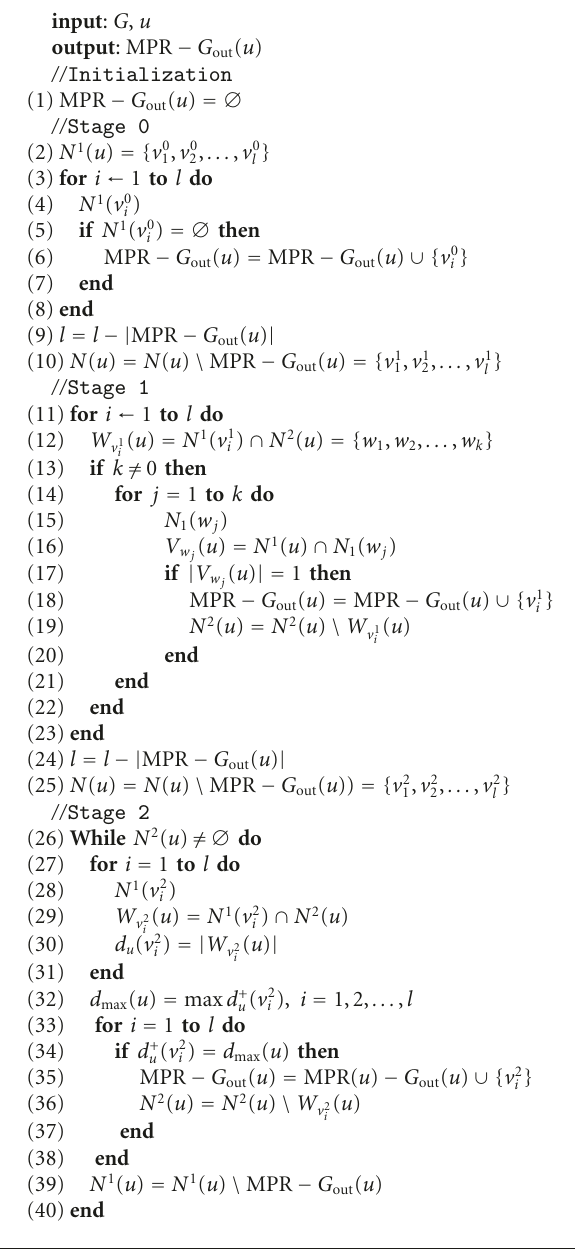
Algorithm 2: MPR − G out